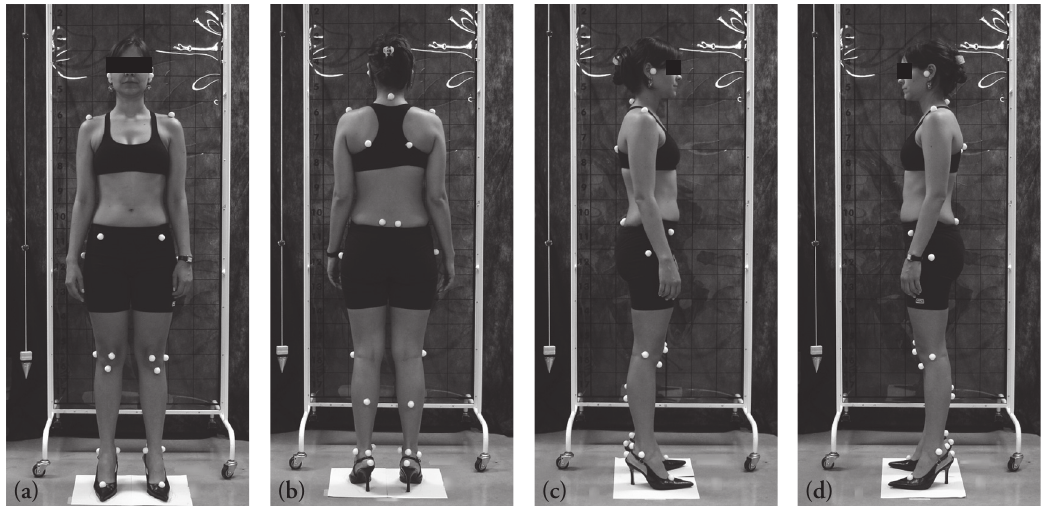
Figura 1 - Análise postural estática com o programa SAPO - (a) vista anterior, (b) vista posterior, (c) vista lateral direita e (d) vista lateral